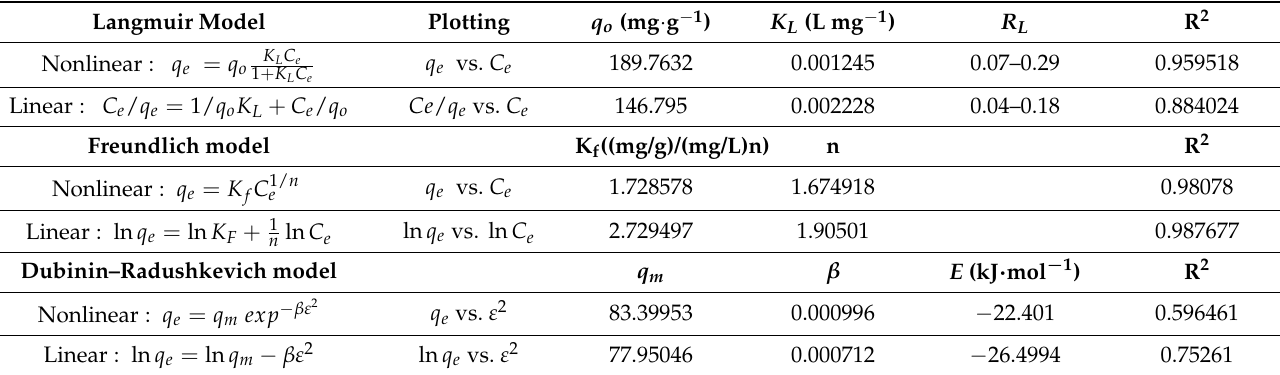
Table 5. Obtained data from fitting experimental results with the three tested (linear and non-linear) isotherm models. Langmuir